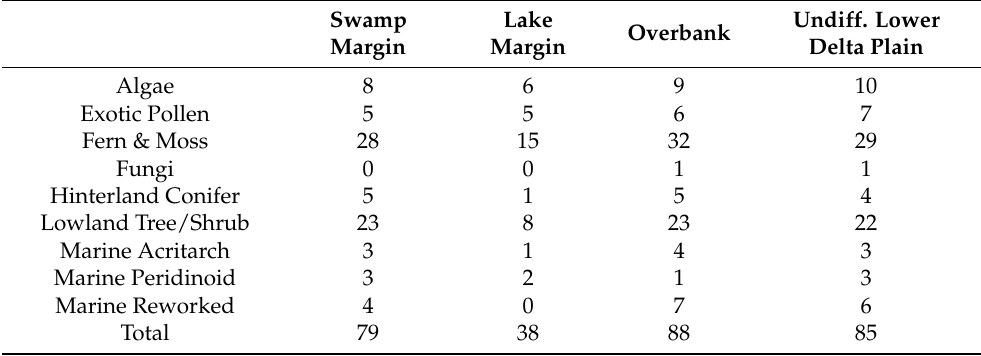
Table 8. Raw taxonomic richness (number of genera) of each depositional